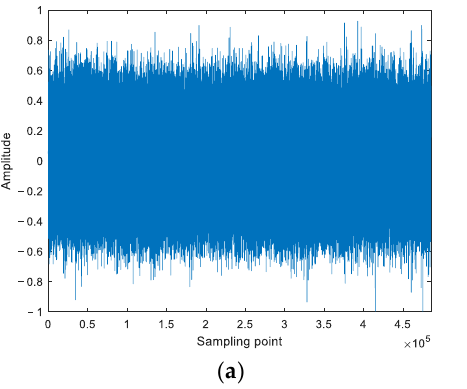
Figure 3. The flowchart of the proposed feature extraction methods.